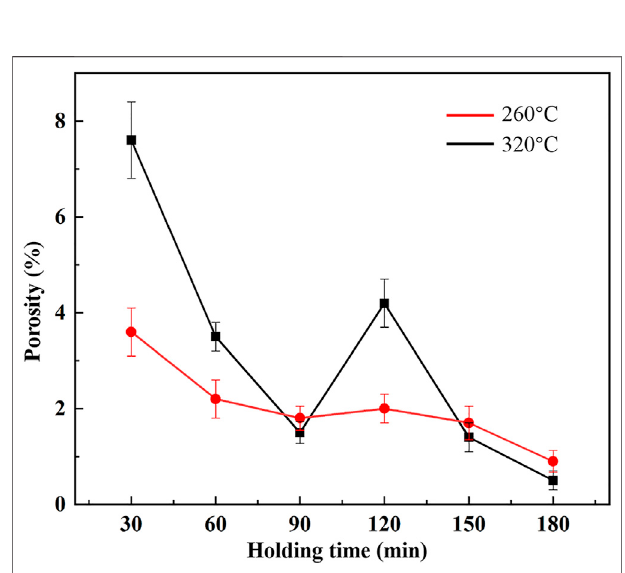
FIGURE 8 | Porosity with different holding times at 260 and 320 °